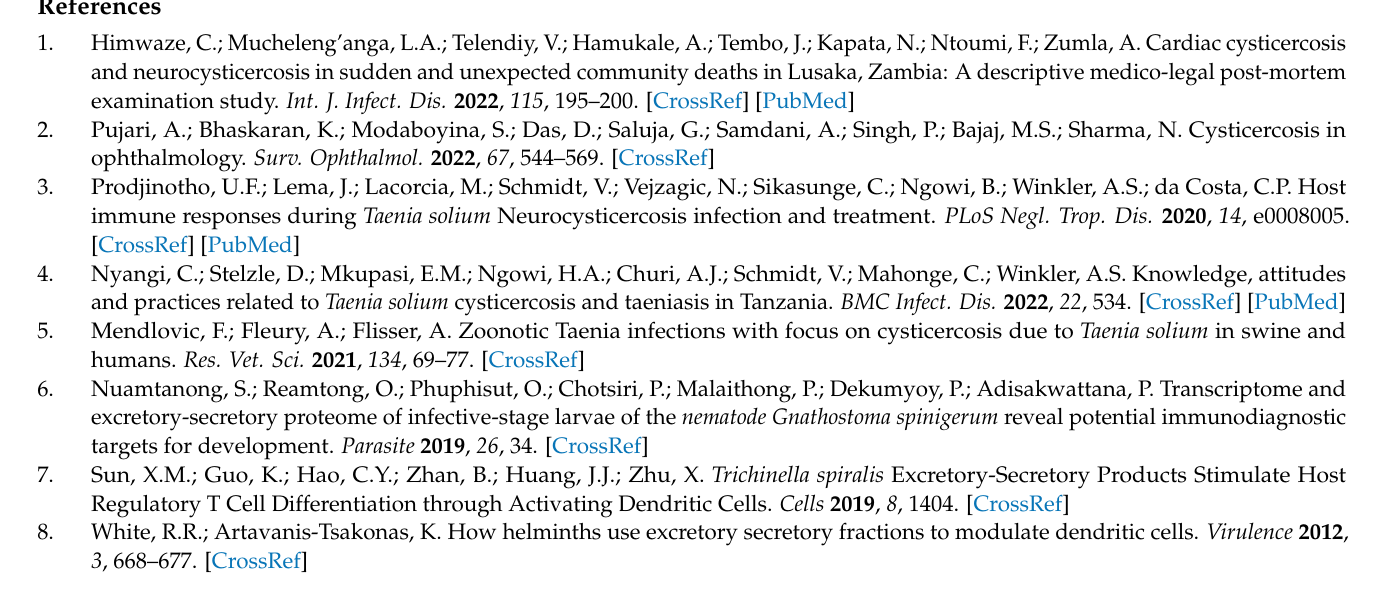
Table S2: TGF-BETA Signaling Pathway; Table S3: Th17 cells differentiation